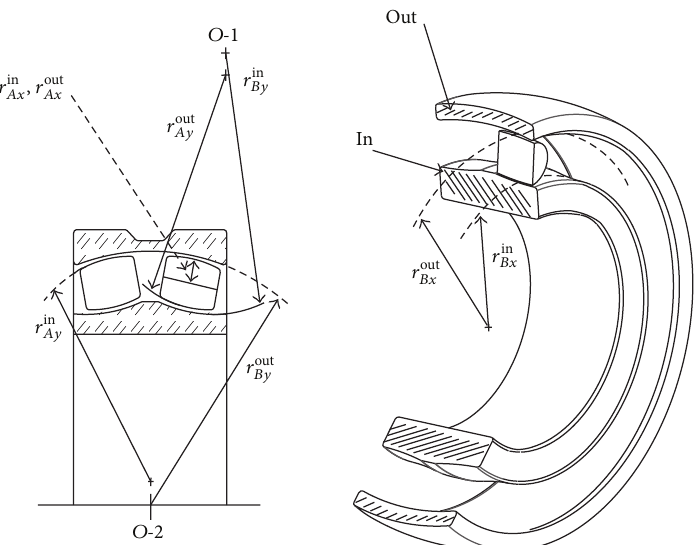
Figure 4: Radii of curvature between roller, outer race, and inner